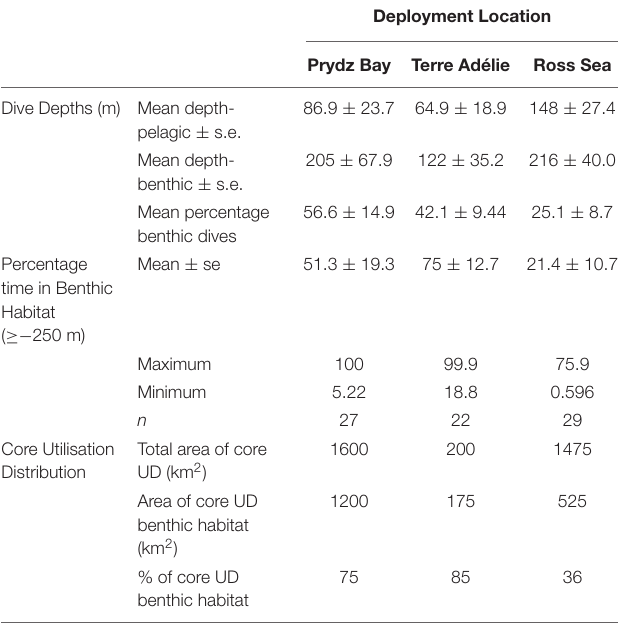
TABLE 2 | Benthic Habitat: the role of benthic habitat on Weddell seal distribution and behaviour.